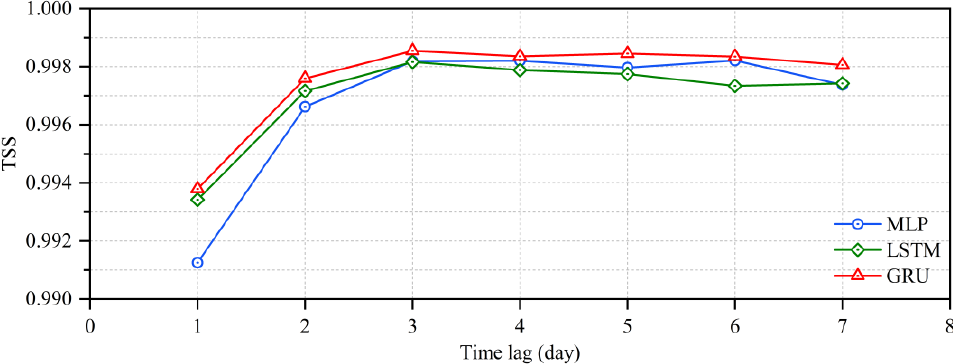
Figure 12. TSSs of the MLP, LSTM and GRU models for water level hydrograph prediction of Shashi Station during the testing period.